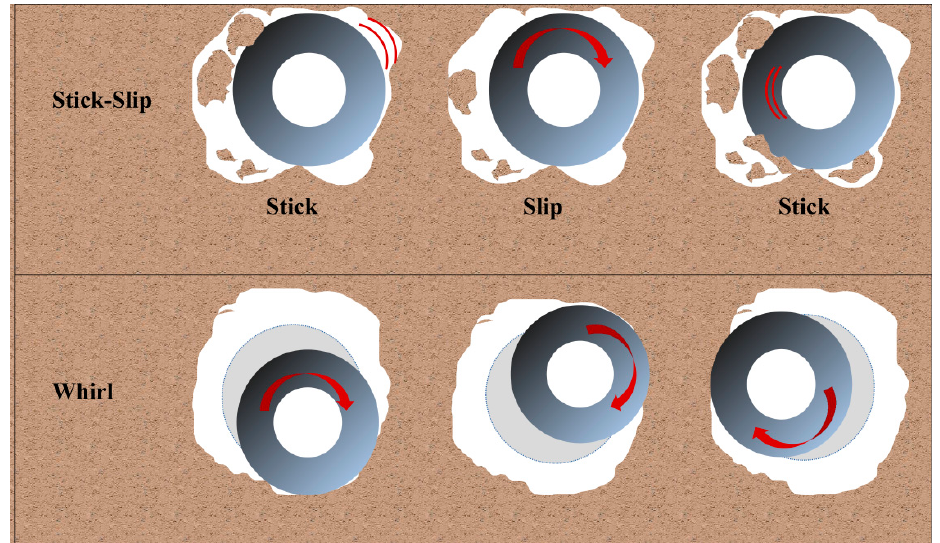
Figure 9. Schematic diagram of stick ‐ slip and whirl.